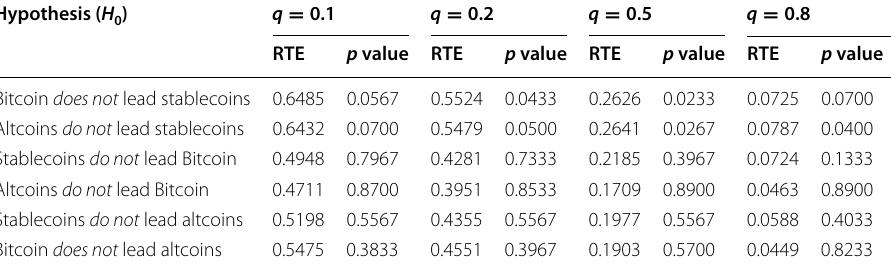
Rényi transfer entropy is estimated following Dimpfl and Peter (2013, 2014) with 2 lags following the short-term Granger causality specification in Table 4. q < 1 emphasize the least likely, i.e. more unique or extreme, events so that q → 0 is dominated by the most extreme events